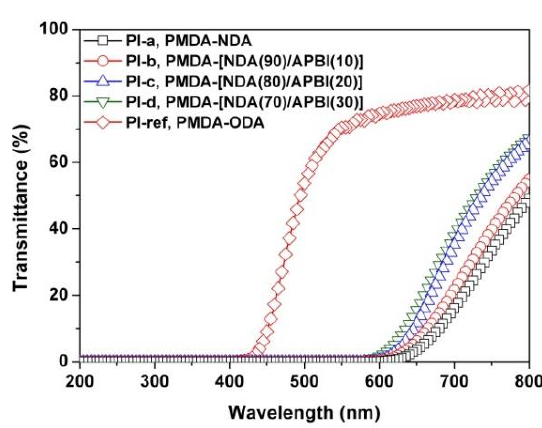
Figure 6. UV-Vis spectra of black PI and PI-ref films. Table 2. Optical and thermal properties of PI films.